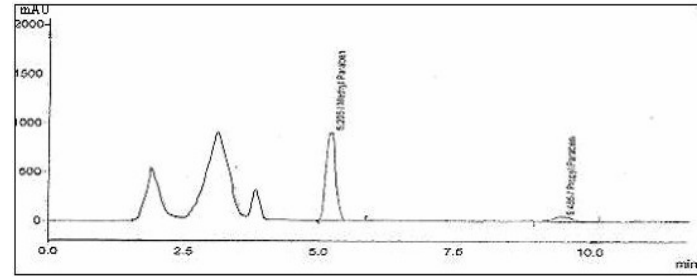
Figure 3. Filter paper saturation at 7 mL